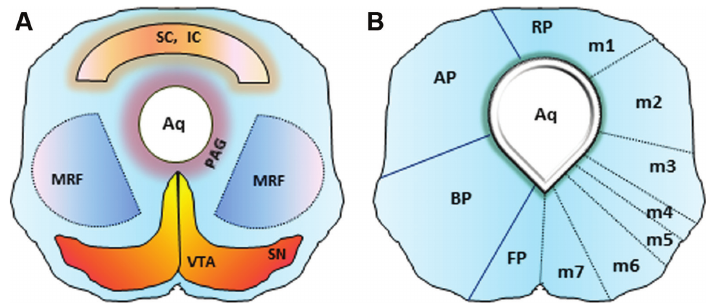
(A) Schema of location of mature midbrain GABA neuronal populations in the superior colliculus (SC), inferior colliculus (IC), midbrain reticular formation (MRF), periaqueductal gray (PAG), substantia nigra (SN) and ventral tegmental area (VTA). Midbrain GABA neuronal populations regulate several brain functions, for instance, they are involved in the SC and IC for sensory integration, in the MRF for sleep, PAG for nociception and defensive behavior, SN for motor activity and in the VTA for motivated behavior. (B) Coronal schematic section of the embryonic mesencephalon depicting its patterning along the dorso-ventral axis into roof plate (RP), alar plate (AP), basal plate (BP) and floor plate (FP) on the left side along with dorso-ventral subdivisions on the right (m1–m7). Aq,